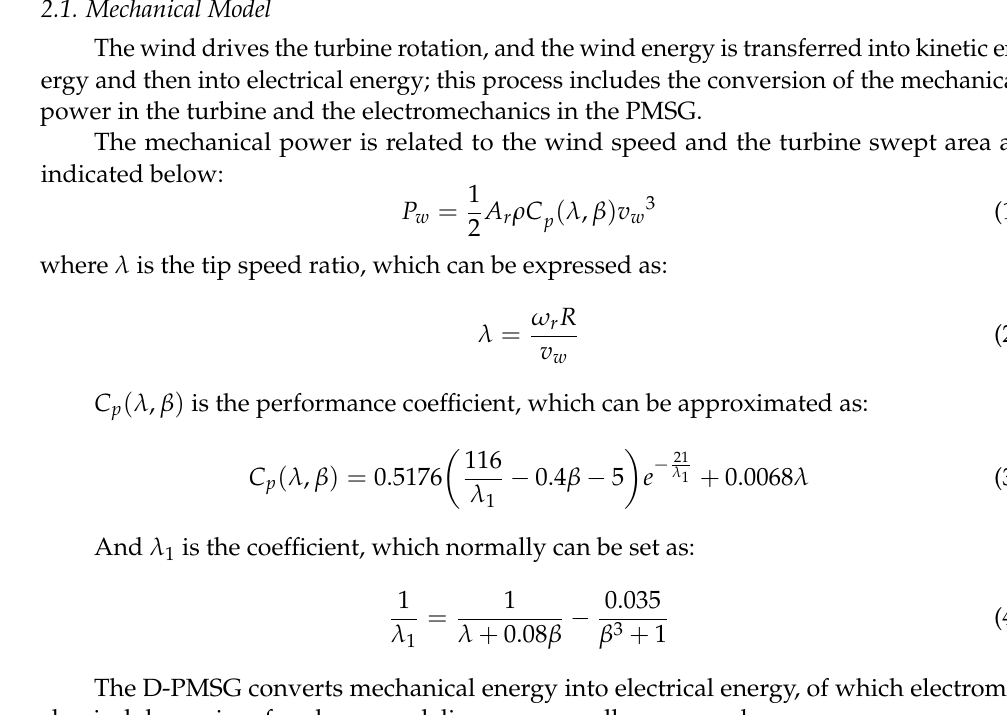
Figure 1. D-PMSG topology and control scheme.